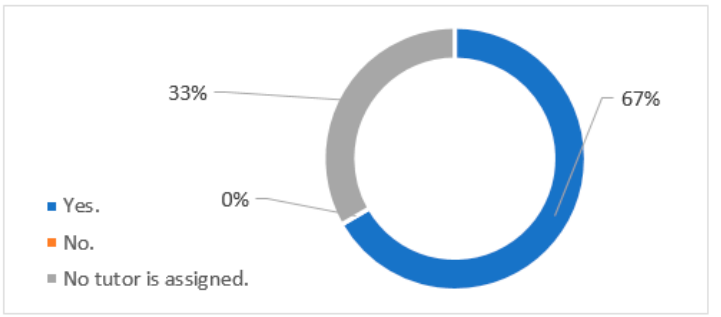
Figure 2. In the process of joining the company, workers with disabilities are usually assigned a tutor. Does this person also have some kind of disability?